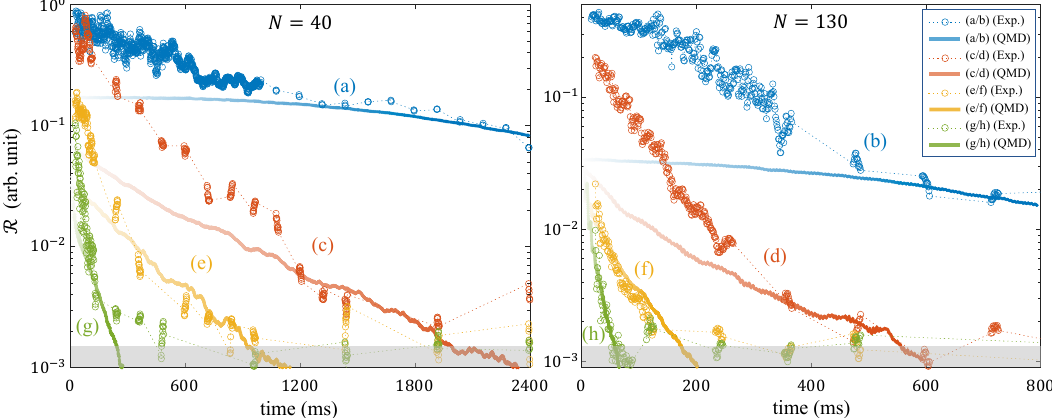
Figure 10: Evolution of R ( t ) for the dynamics initialized by the distributions shown in Fig. 3. The results are labeled consistently with Fig. 3. The dynamics of quasimo- mentum distribution (QMD) calculated in MD simulations (solid curves) are in good agreement with the experimental measurements (open circles) in Stage II of each evolution. The faded-out parts of MD results deviate from the experimental mea- surements due to the discrepancy between MDF and quasimomentum distribution in the regime far from the non-degenerate limit. The shaded areas indicate the noise